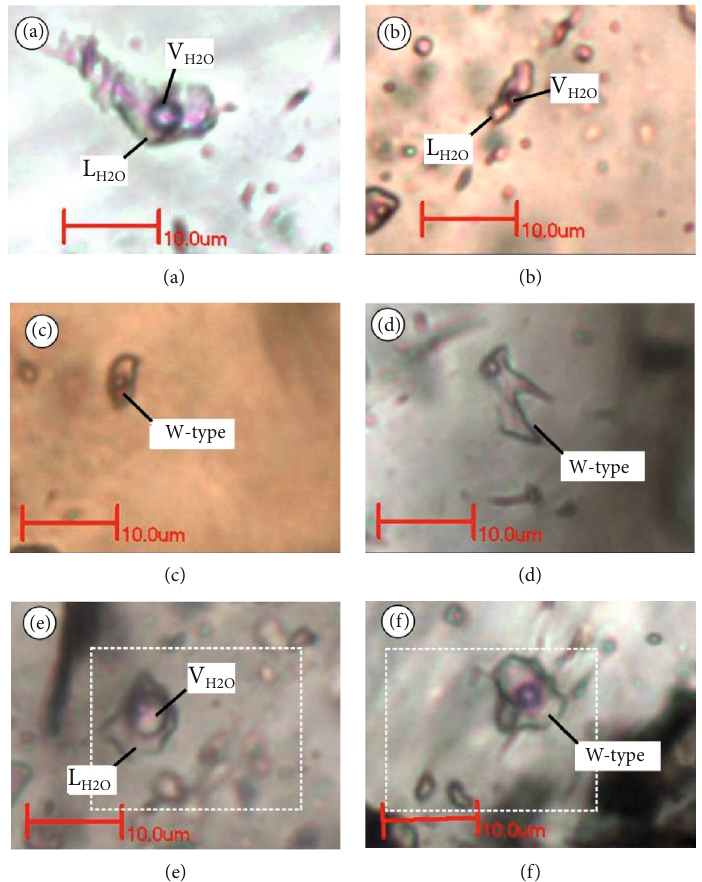
O and liquid H O; (e – f) 2 2